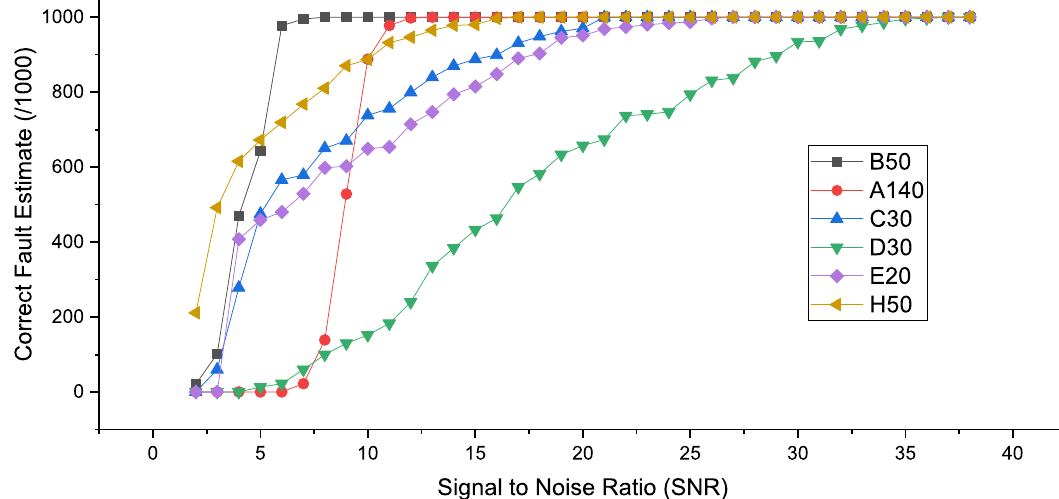
Figure 13. Signal to Noise Ratio versus the number of correct fault estimates out of 1000 for 6 representative fault positions on the IEEE 13-bus